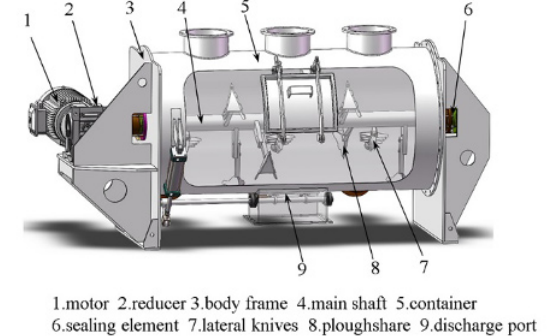
Fig. 1. The model of ploughshare